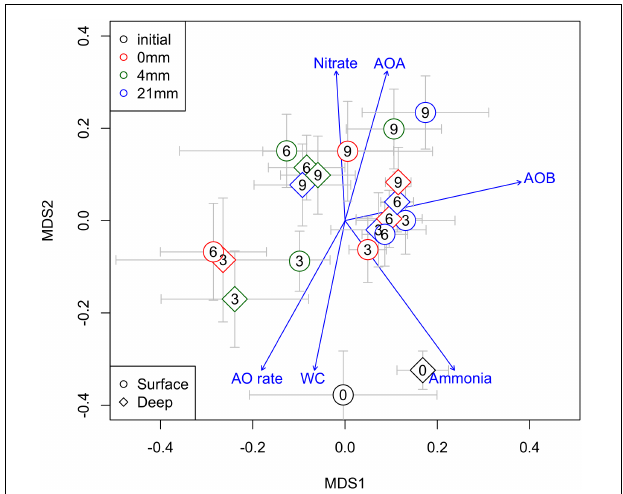
FIGURE 5 | Non-metric multidimensional scaling ordination (nMDS) of all prokaryotes community showing AOA and AOB (RA) in relation to a suit of chemical and biogeochemical variables of sediments (WC%, nitrate and ammonia concentration and AO rates) potentially associated across the different DPDs. The different DPDs ( t = 0, 3, 6, and 9 weeks) are reflected by numbers within the symbols. Different symbols shapes and colors denote different sediment layers sediments and different RMs,